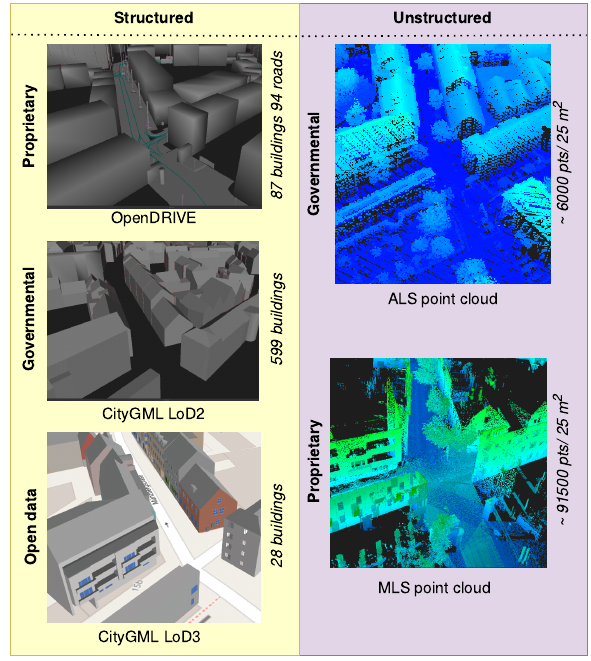
Figure 7. Overview of the Ingolstadt datasets Core i7-8750H CPU @2.20GHz as processor, 16GB for memory (RAM) and Windows 10 as operating system.